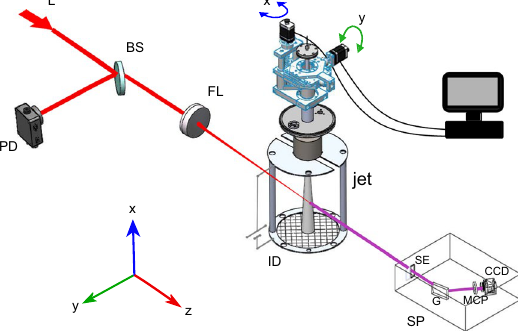
Figure 1. Schematic of the experimental setup. L-laser; BS-beam splitter; PD-photodiode detector; FL-focusing lens; ID-ion detector; SP-spectrometer; SE-spectrometer slit;